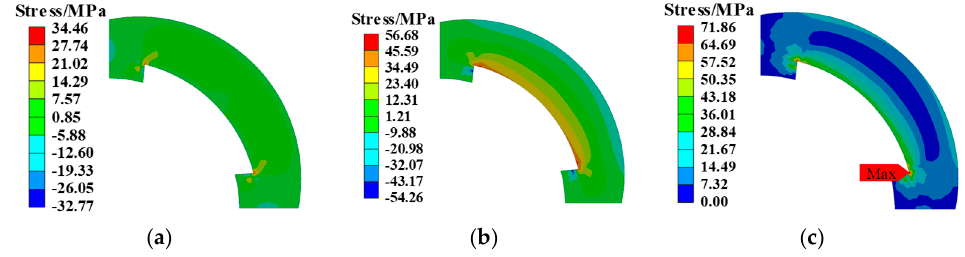
Figure 15. Distribution of PM stress with SIPM1. ( a ) Radial stress. ( b ) Tangential stress. ( c ) Equiva- lent stress.